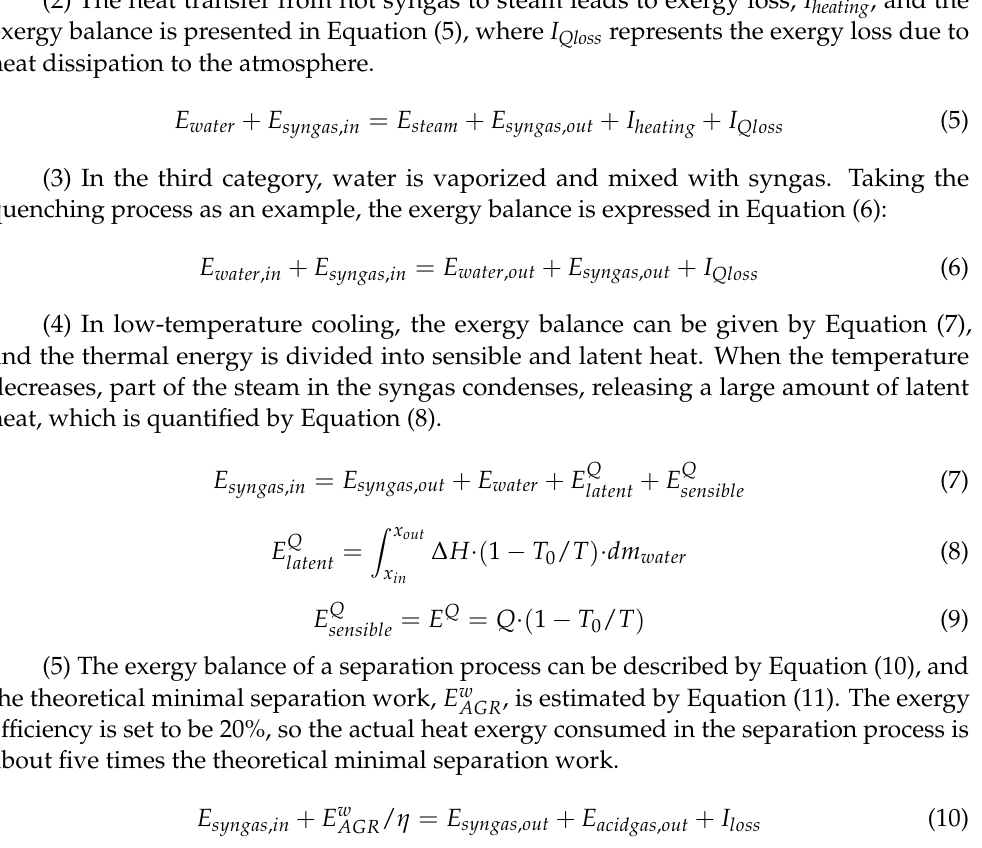
Figure 3. Exergy balance of several key components in polygeneration systems. ( a ) Gasifier; ( b ) Methanol synthesis.